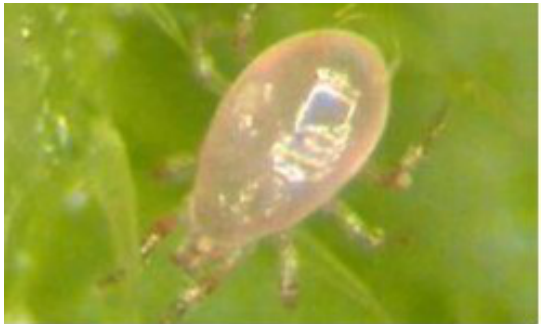
Figure 1. The predatory mite, Amblyseius swirskii (UK Crown Copyright ©